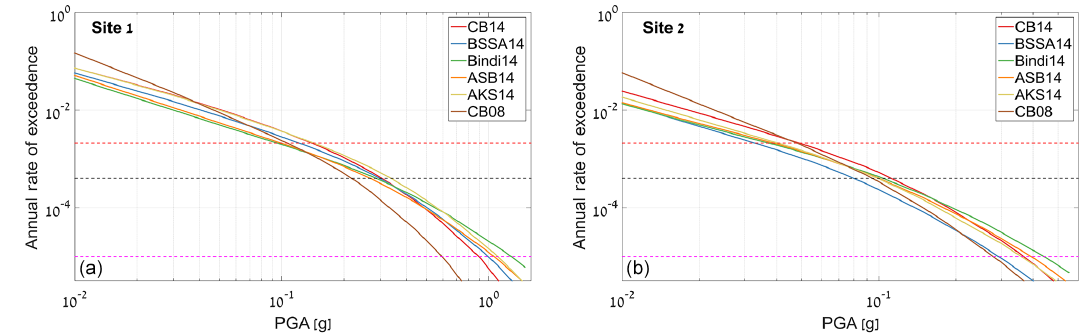
Figure 12. Hazard curves for model 5, using the average weighted values, at (a) site 1 and (b) site